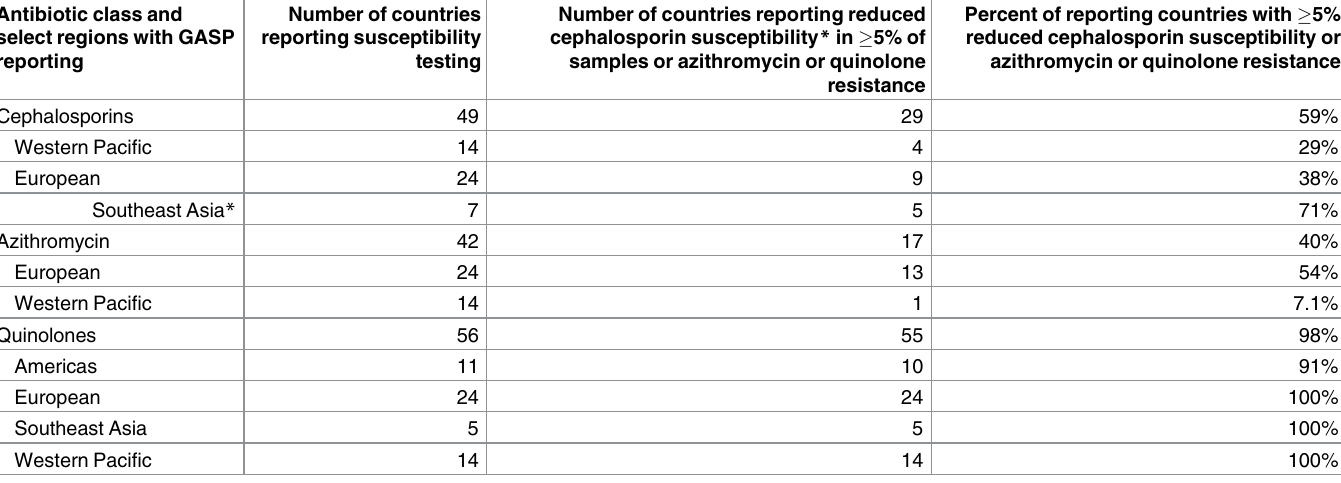
Table 2. Gonococcal reduced susceptibility to cephalosporins and resistance to azithromycin or quinolones, as reported by countries and regions through the 2012–2013round of GASP. Antibiotic class and select regions with